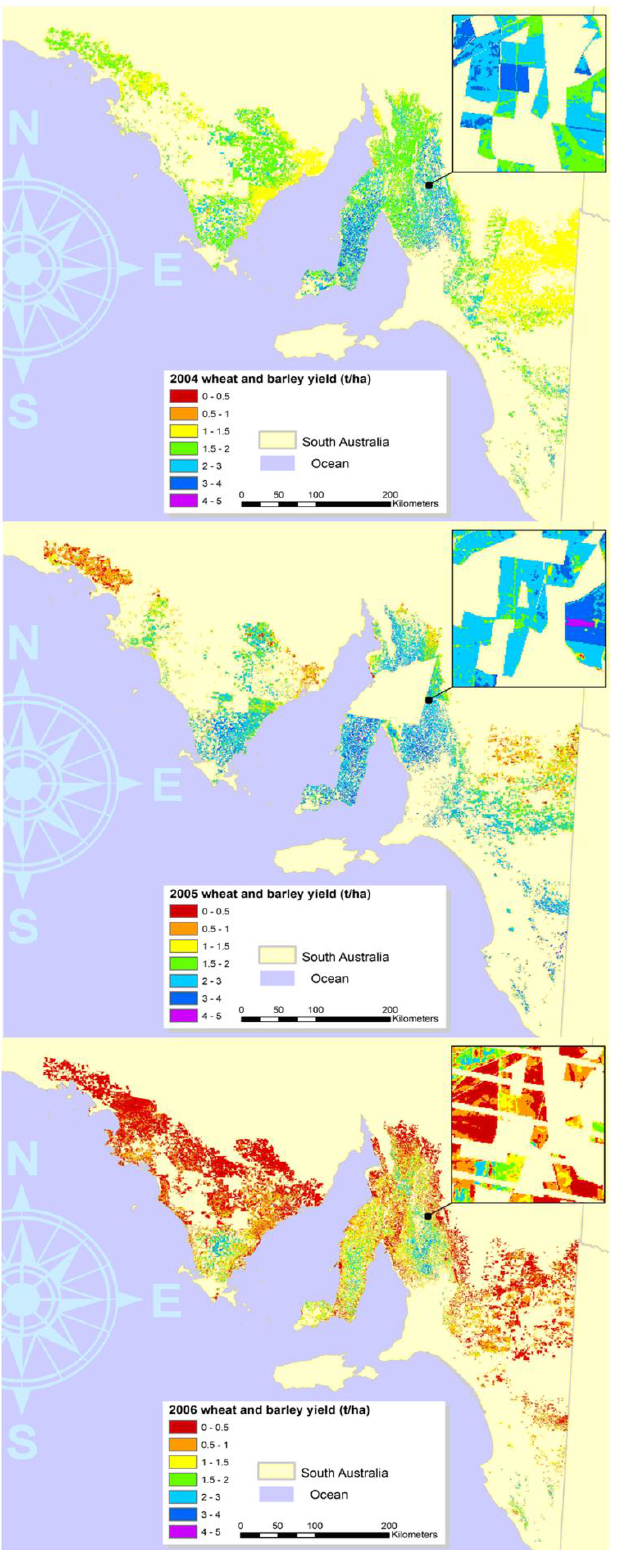
Figure 4. Predicted high-resolution yield estimates from yield–NDVI relationships for the state-wide analysis for 2004 and 2005 to 2006. Insets show the fine resolution at which yield is estimated, highlighting yield patterns within a field across the state-wide study area.